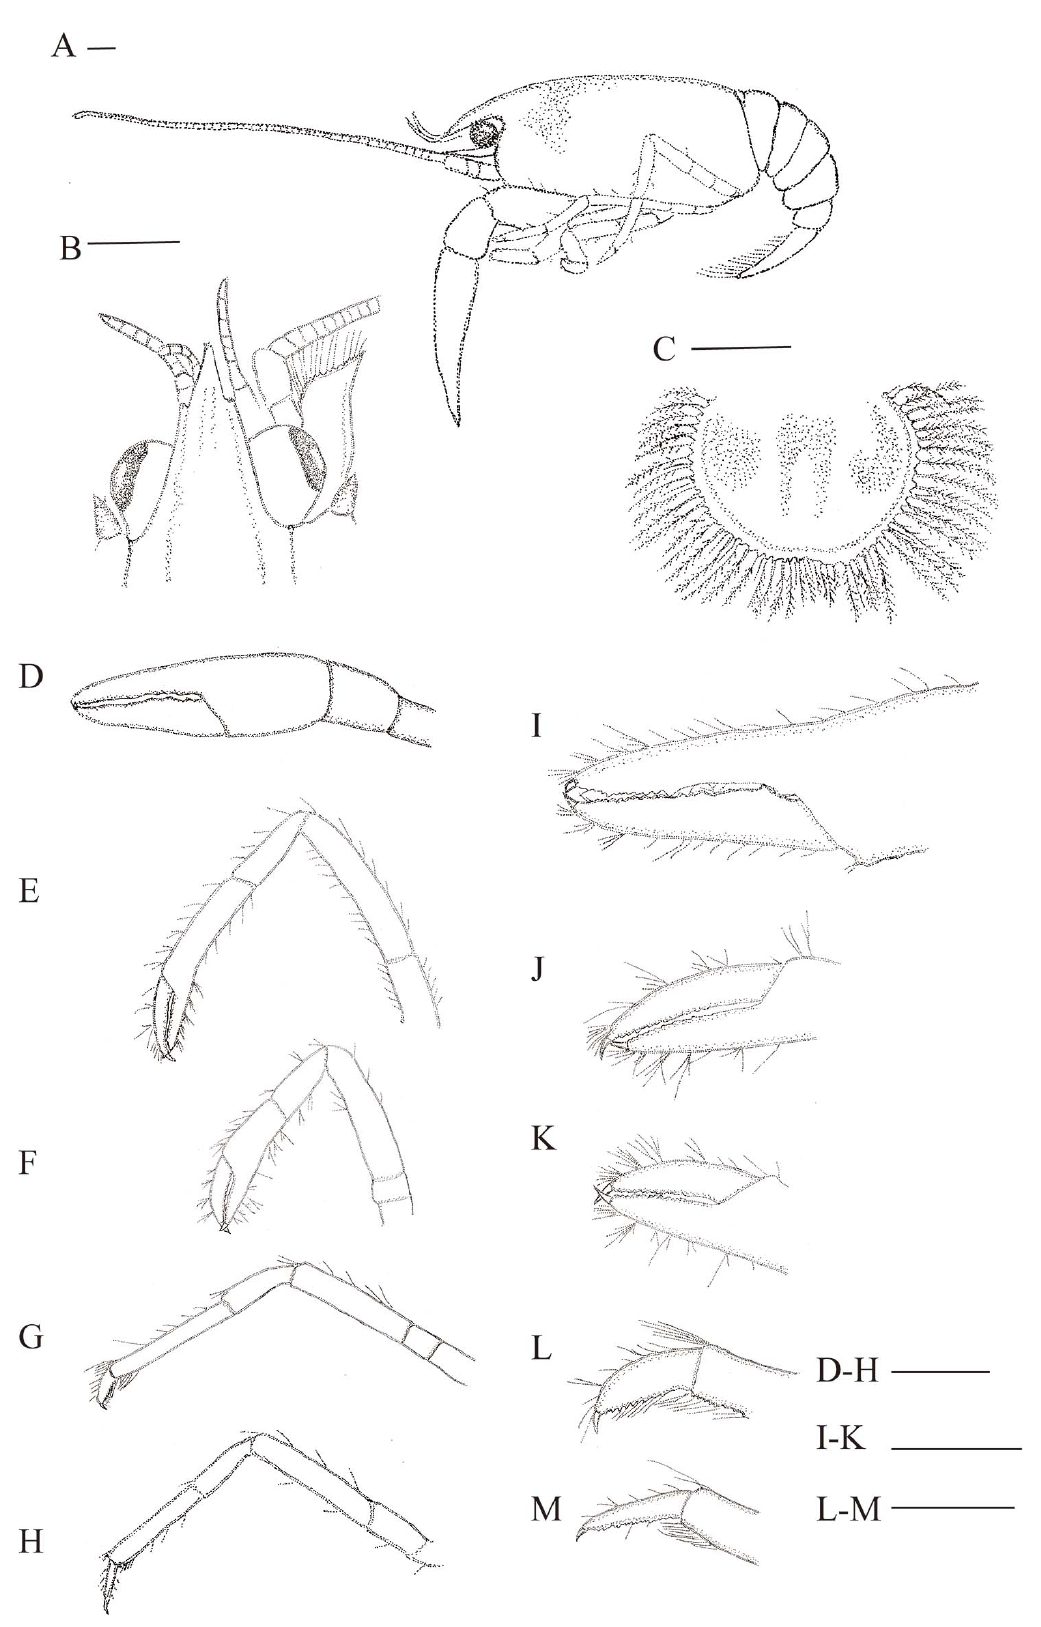
Figure 3. Juvenile Stage II of Austropotamobius torrentium . ( A ) Habitus, lateral view; ( B ) eyes and rostrum, dorsal view; ( C ) tail fan, dorsal view; ( D–H ) pereiopods 1–5, dorsal or lateral view; ( I–M ) distal segments of pereiopods 1–5, dorsal or lateral view. Scale bars: 0.25